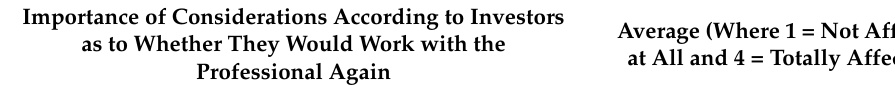
Table 5. Importance of risk factors influencing continuity according to investors’ views (average, where 1 = not at all important 4 = absolutely